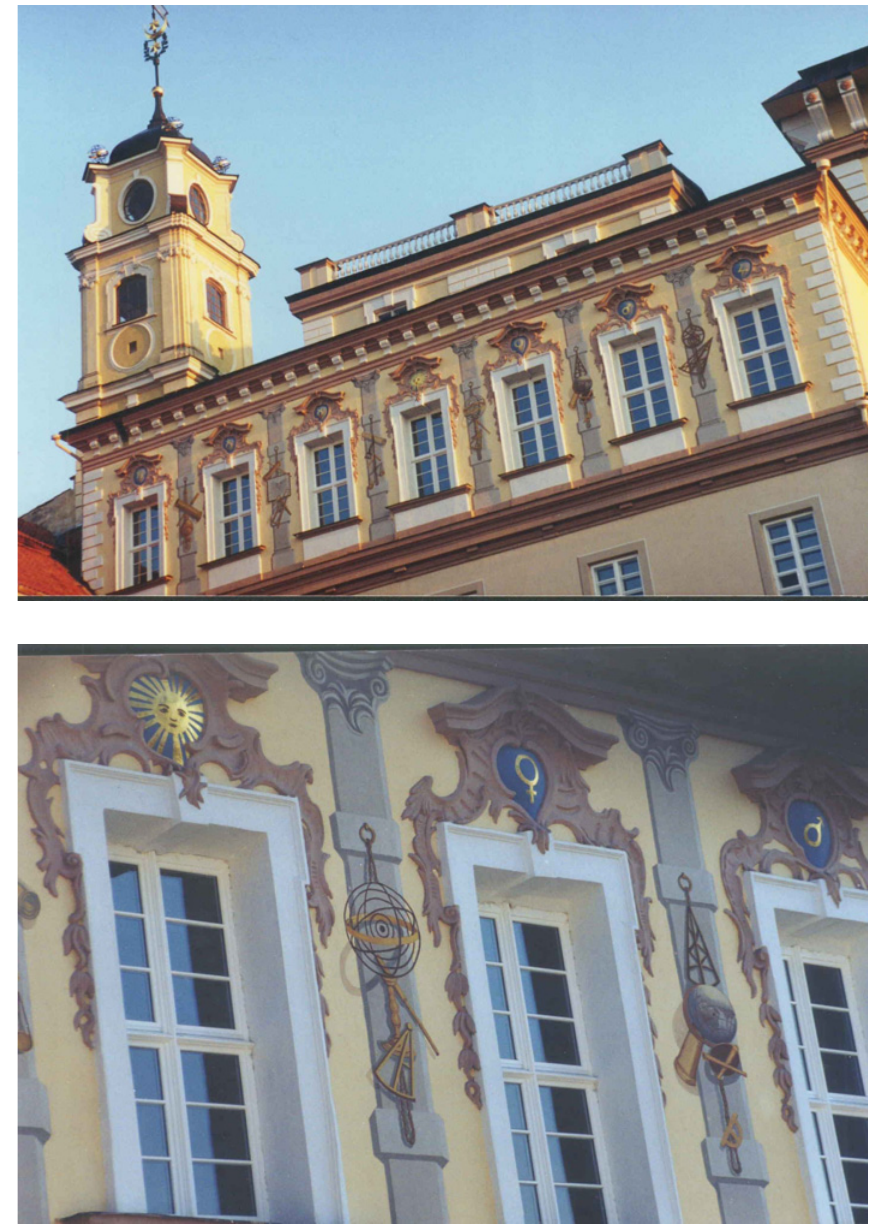
Fig. 2. Top: a view of the Observatory from the Library courtyard; bottom: windows of the